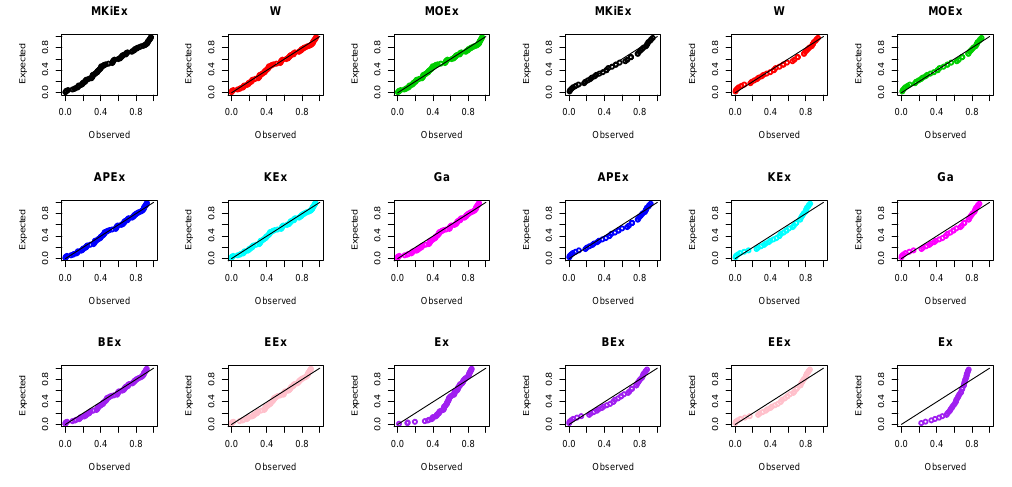
Figure 6. PP plots for data I ( left ) and data II ( right